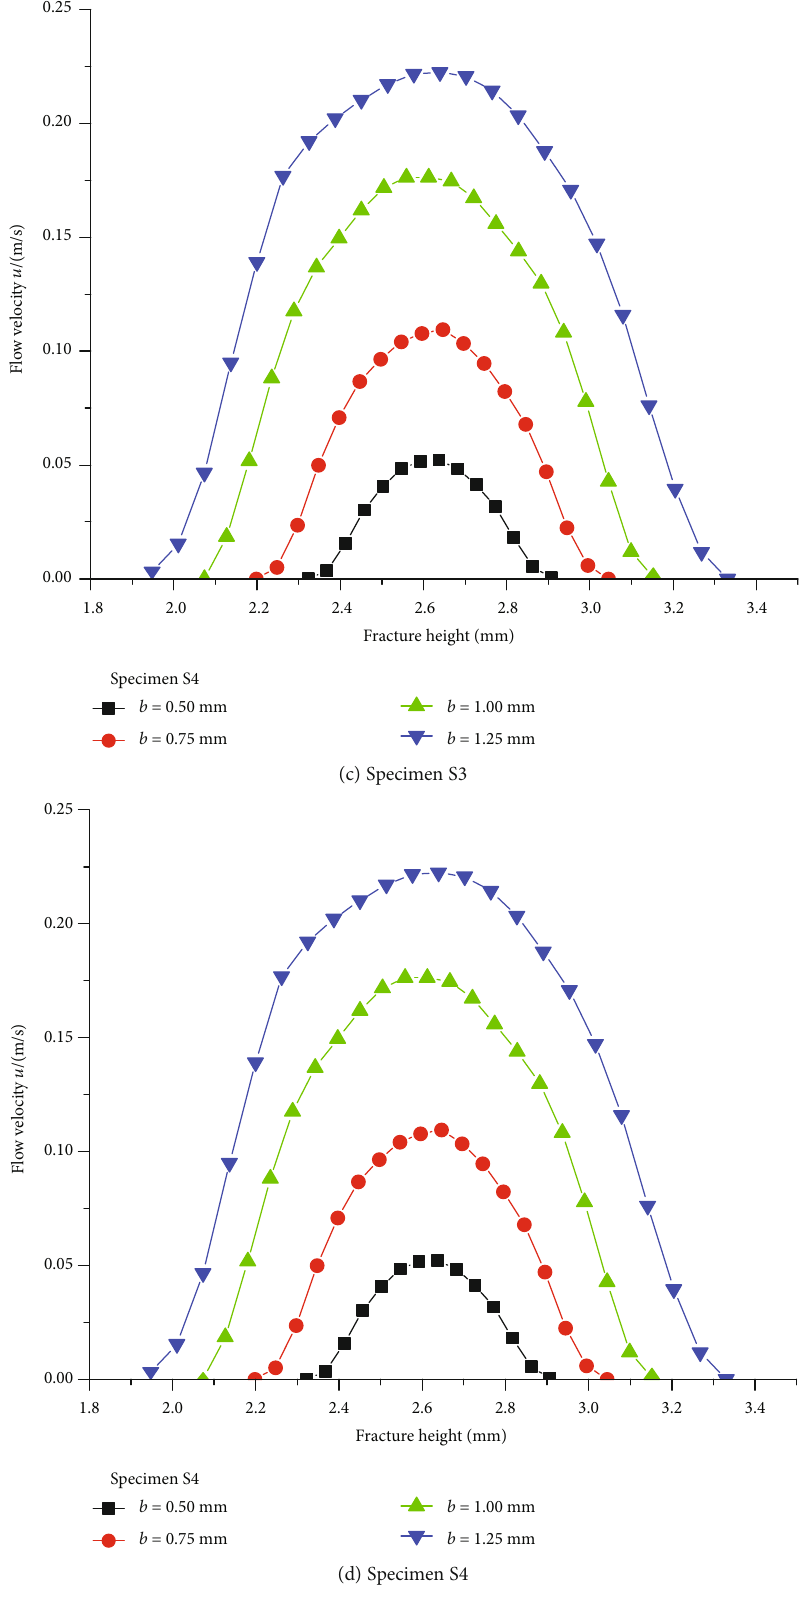
Figure 14: Comparison of fl ow velocity of fractures in samples S1-S4 considering varied